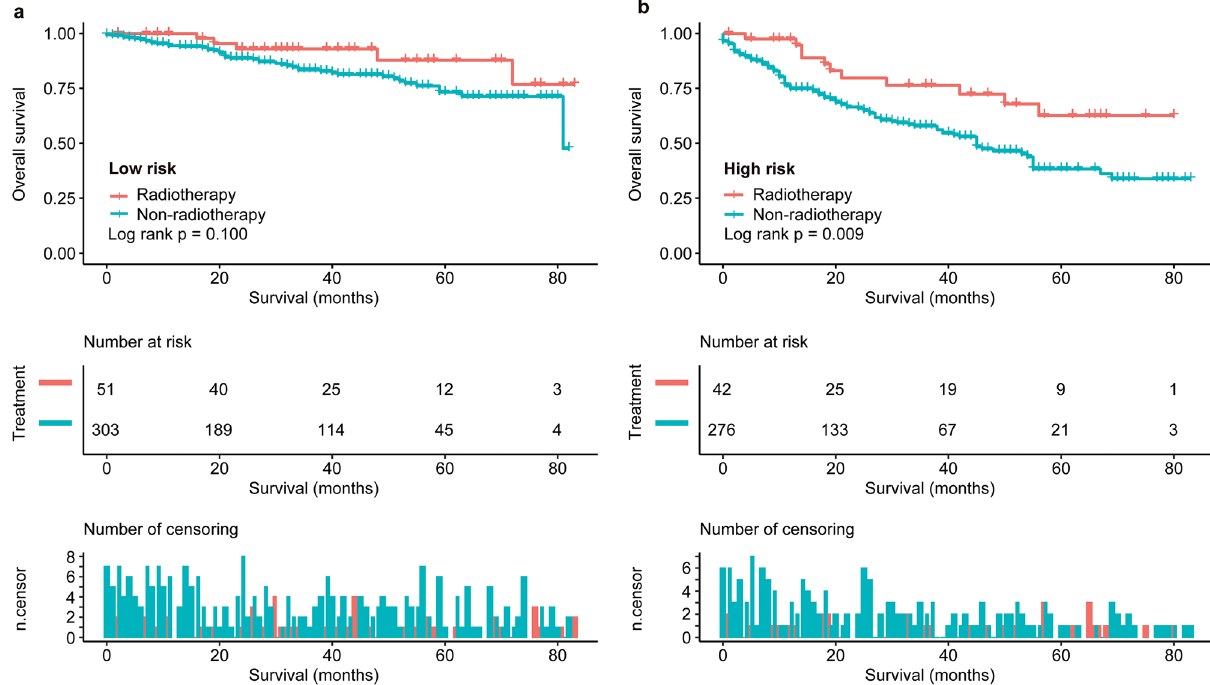
Figure 4. Overall survival (OS) rates according to ( a ) radiotherapy for low ‐ risk patients (radiotherapy vs. non-radiotherapy, P = 0.100) and ( b ) radiotherapy for high ‐ risk patients (radiotherapy vs. non-radiotherapy, P = 0.009). Pictures show the number of subjects at risk in each group at 20-month increments. Pictures show the number of censoring in each group at 20-month increments.